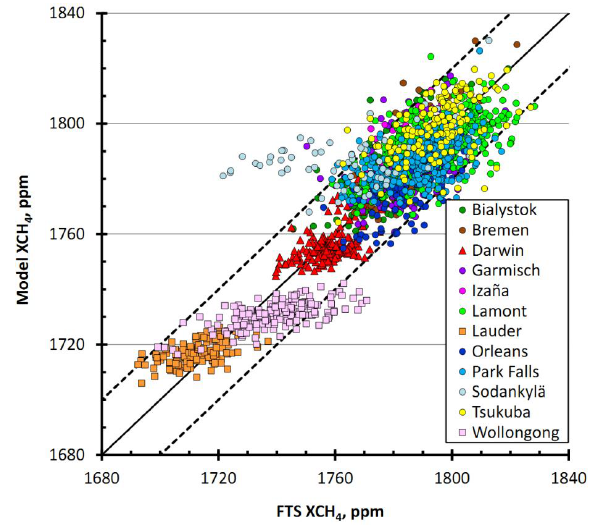
Fig. 11. Scatter diagram of modelled and FTS XCH 4 at all FTS sites. Dotted lines show a standard deviation of ± 1% of XCH 4 .